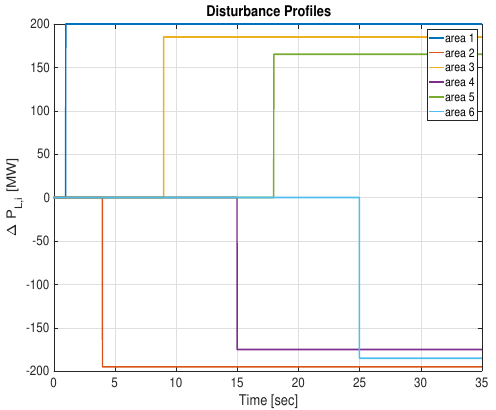
Figure 6. Power demand deviation ∆ P L , i for i = 1, · · · ,6.